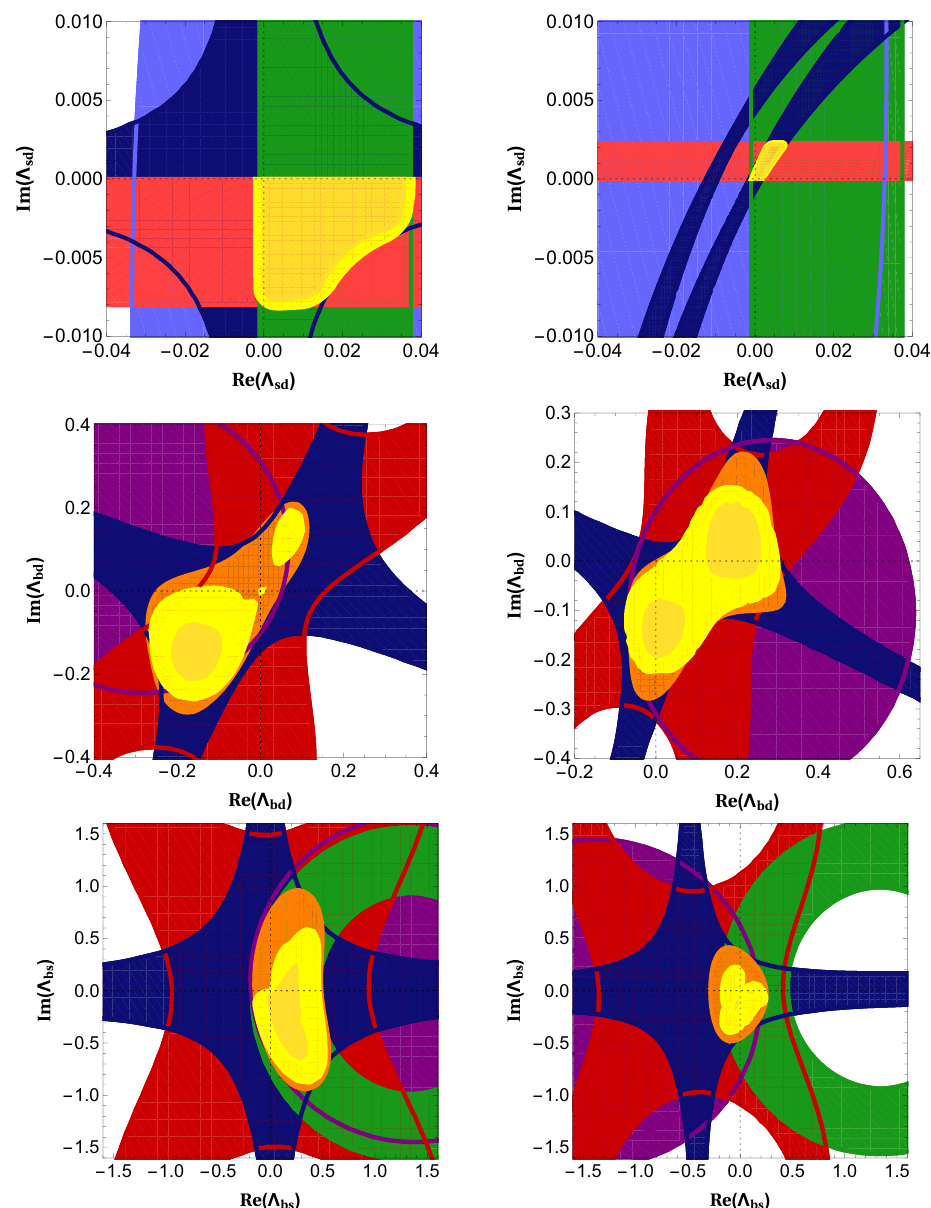
Figure 5. Fits of Im((cid:3) ij ) vs. Re((cid:3) ij ) for ij = sd; bd; bs [upper, middle, lower] in G SM -scenarios D [left] and Q V [right] for M VLQ = 10 TeV. Constraints from single observables and the combined (cid:12)t for each separate sector [orange] are shown at 95% CL, the global (cid:12)t [yellow] at 68% and 95%. For ij = sd : " K [dark blue], Br ( K + For ij = bd : (cid:1) M d [dark red], sin(2 (cid:12) d ) [dark blue] and Br ( B + (cid:1) M s [dark red], sin(2 (cid:12) s ) [dark blue], Br ( B s